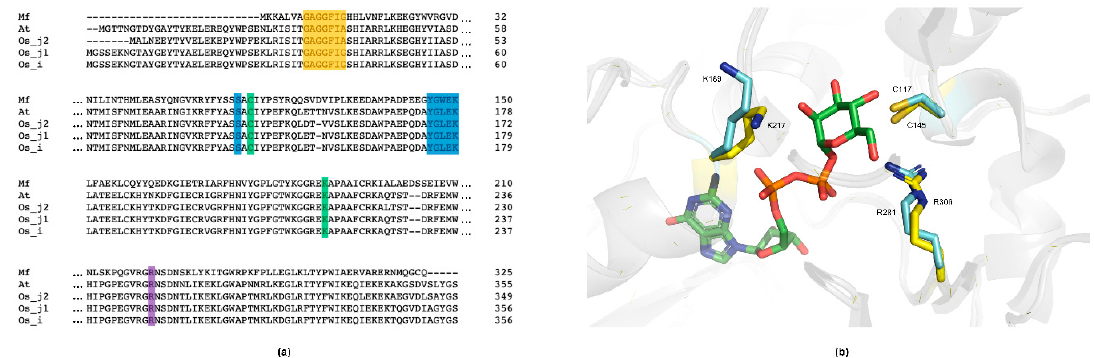
Figure 4. Sequence and structural analysis of MfGM35E. ( a ) Multiple sequence alignment of the GM35Es from Methylacidiphilum fumariolicum (Mf), Arabidopsis thaliana (At), Oryza sativa subsp. japonica (Os_j), and Oryza sativa subsp. indica (Os_i). Yellow, GxxGxxG motif; blue, YxxxK motif and upstream serine (S); green, catalytic cysteine (C) and lysine (K); purple, conserved arginine (R). ( b ) Representation of the active site of MfGM35E (blue) and AtGM35E (yellow). The catalytic C and K are highlighted, as well as the conserved R. GDP-mannose is colored by element (green).